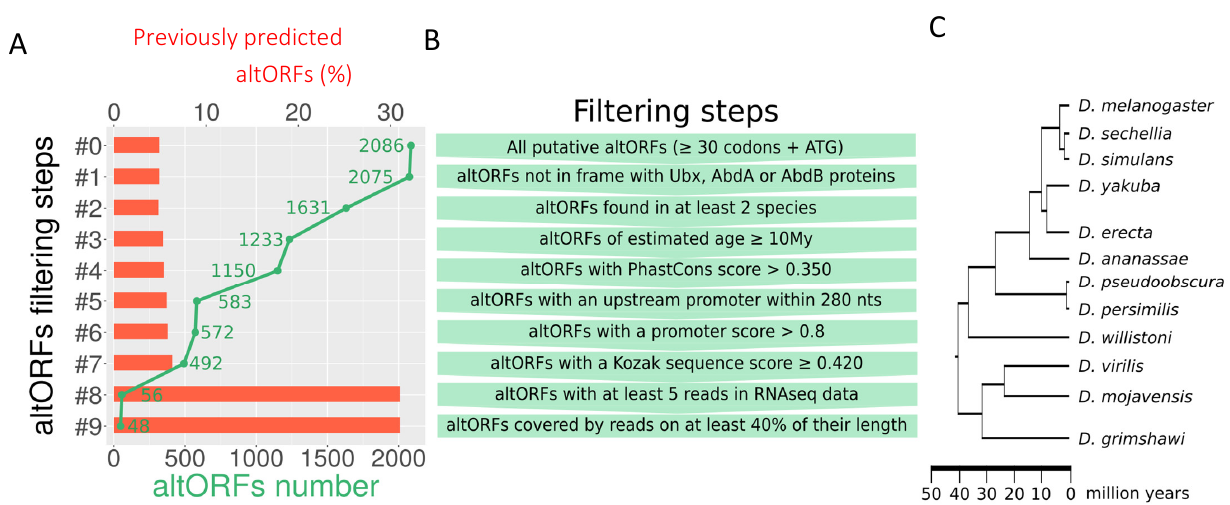
Figure 1. Identification of altORFs in the BX-C region of Drosophila melanogaster . ( A ). Total number of predicted altORFs (green curve) across the 9 different filtering steps. The corresponding percentage of previously predicted altORF peptides [33,35] is indicated (red bars). ( B ). Criteria applied across the different filtering steps. The threshold values used for selecting most relevant altORFs were based on scores deduced from previously predicted altORF peptides (see also materials and methods). ( C ). Phylogeny of the 12 Drosophila species used for conservation analyses (adapted from [37]).